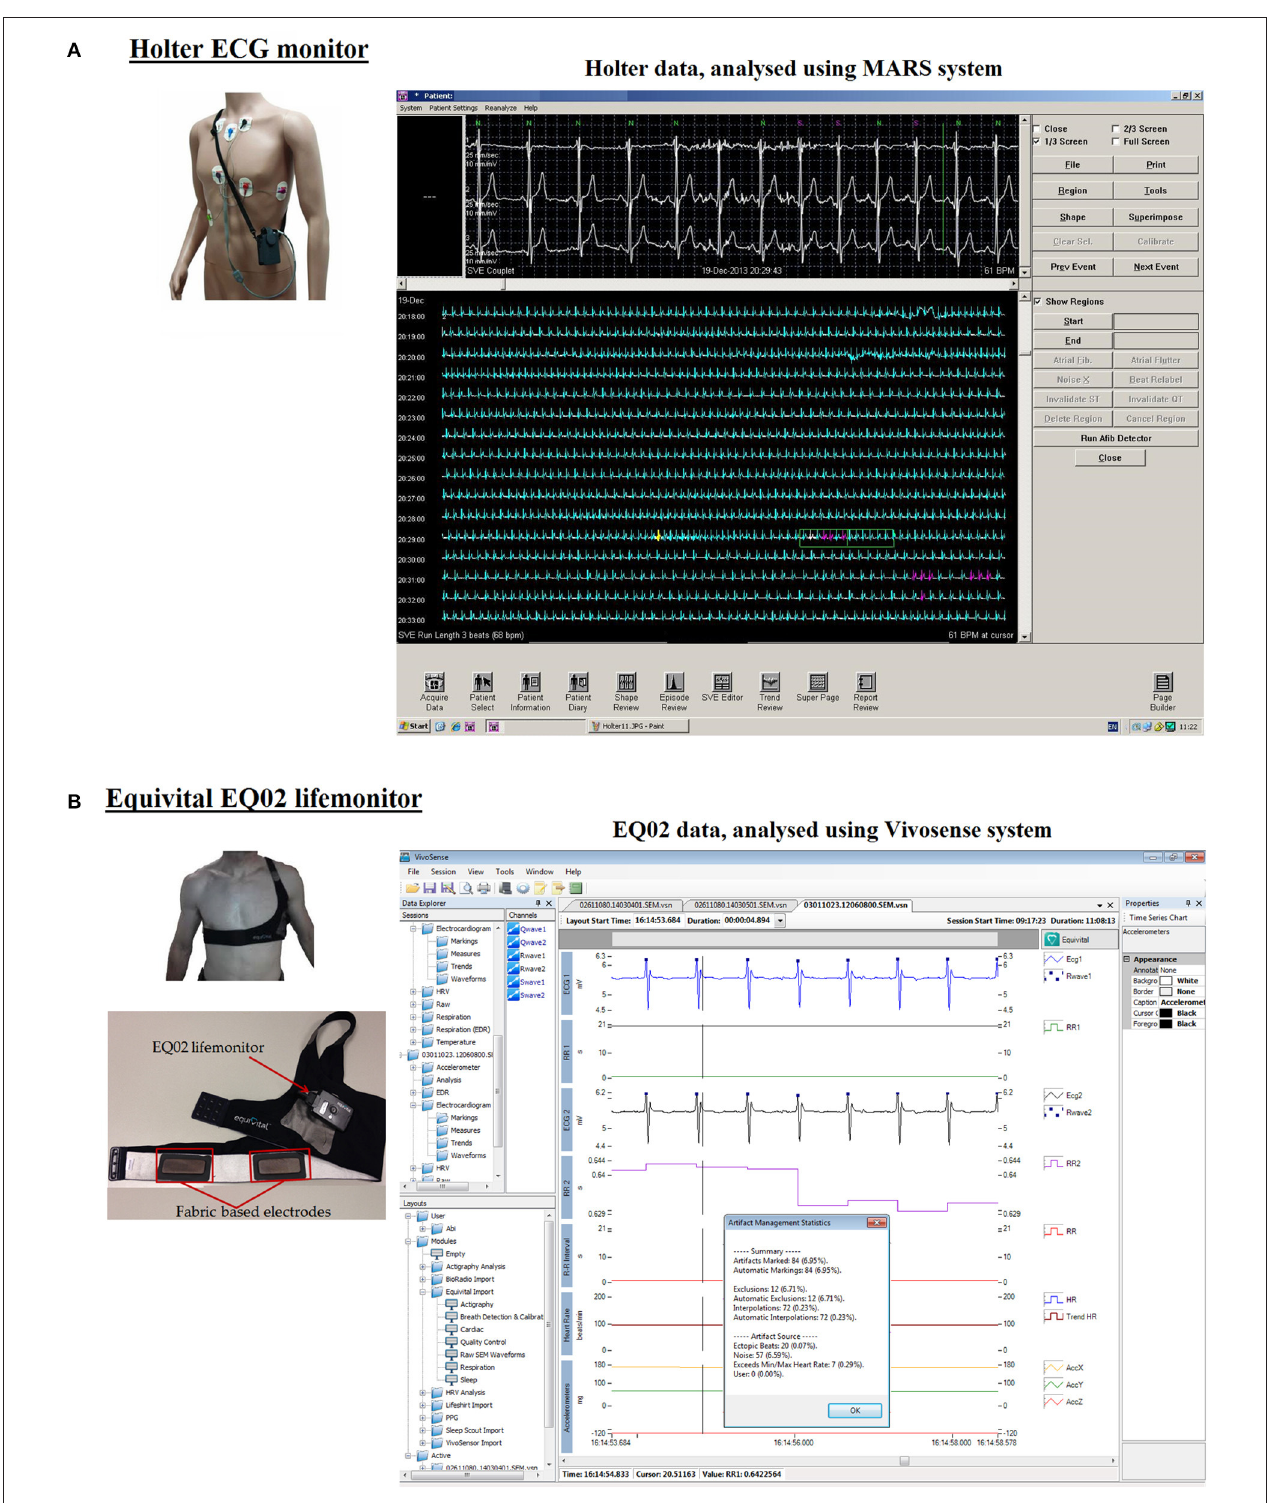
FIGURE 1 | Analysis software for Holter and EQ02 data management. (A) Shows the Holter monitor including its electrodes, lead wires, and its analytical software. Annotated tracings from the Holter can be seen on the MARS software. (B) Shows the EQ02 unit, consisting of the lifemonitor belt on which are three textile-based electrodes. ECG tracings are visualized on the cardiac layout of Vivosense software.